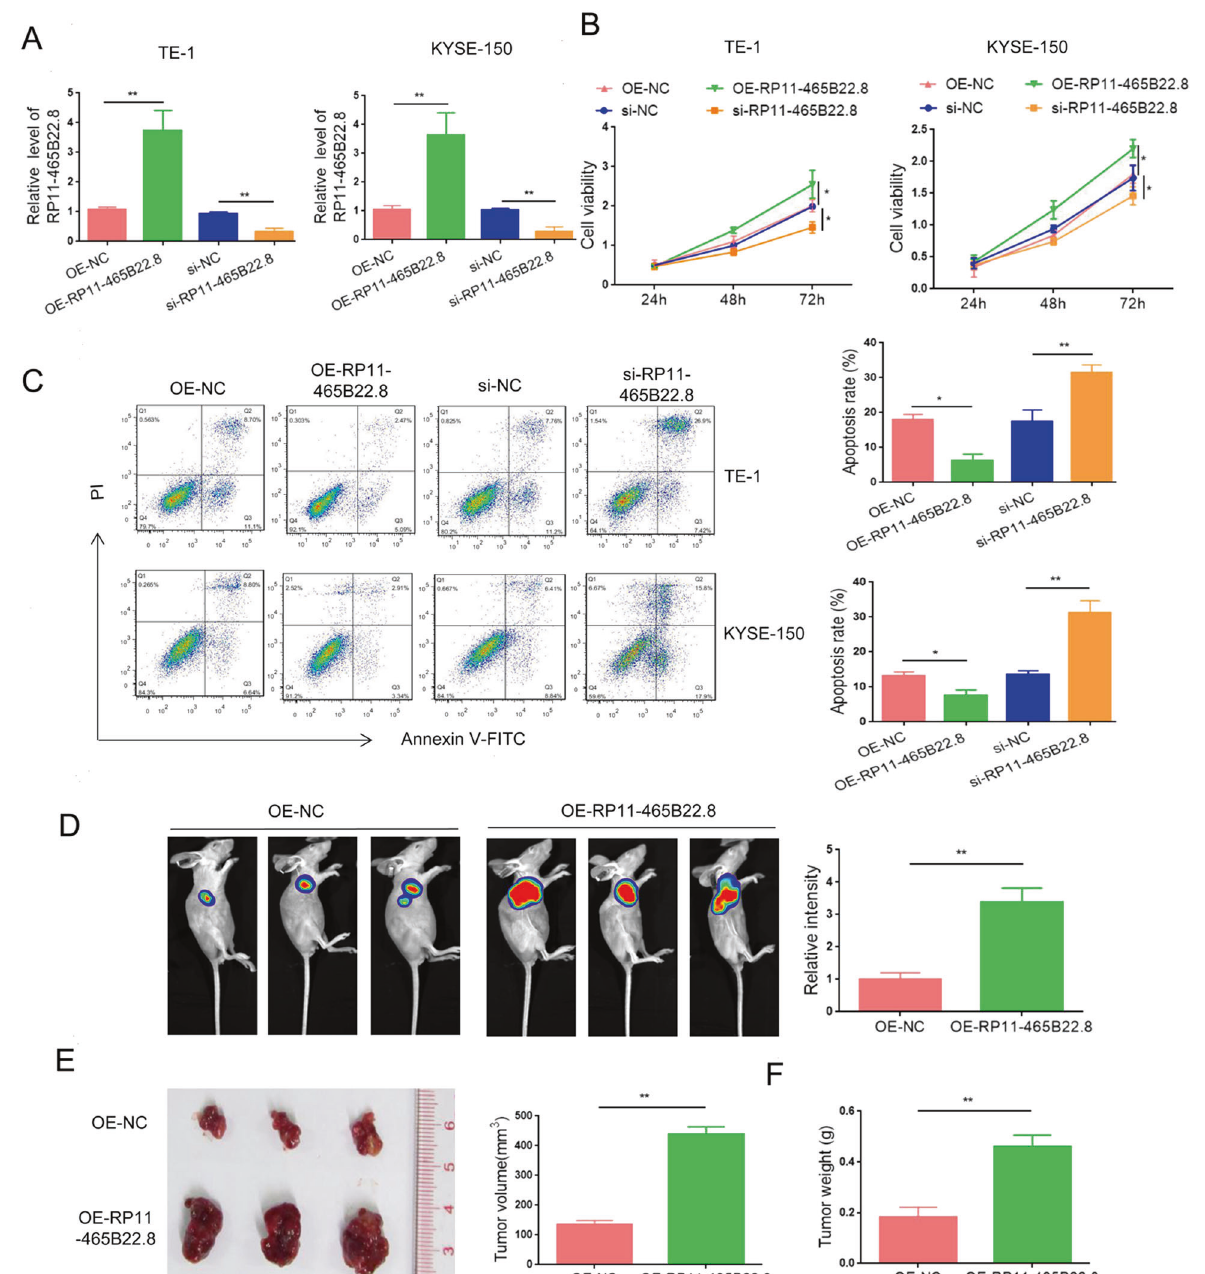
Fig. 2 LncRNA RP11-465B22.8 enhances EC tumorigenesis. A qRT-PCR analysis of lncRNA RP11-465B22.8 expression in EC cells after lncRNA RP11-465B22.8 overexpression or knockdown. B CCK-8 assay analysis of the viability of EC cells after lncRNA RP11-465B22.8 transfection or silencing. C Apoptosis analysis of EC cells following lncRNA RP11-465B22.8 overexpression or depletion. D Luciferase intensity in mice after injection with TE-1 cells expressing lncRNA RP11-465B22.8 or control vector ( n = 5). E Representative images of tumors isolated from mice injected with lncRNA RP11-465B22.8-overexpressed TE-1 cells or control cells ( n = 5). F Tumor weight of tumors formed by TE-1 cells overexpressing lncRNA RP11-465B22.8 or control vector. * P < 0.05, ** P <